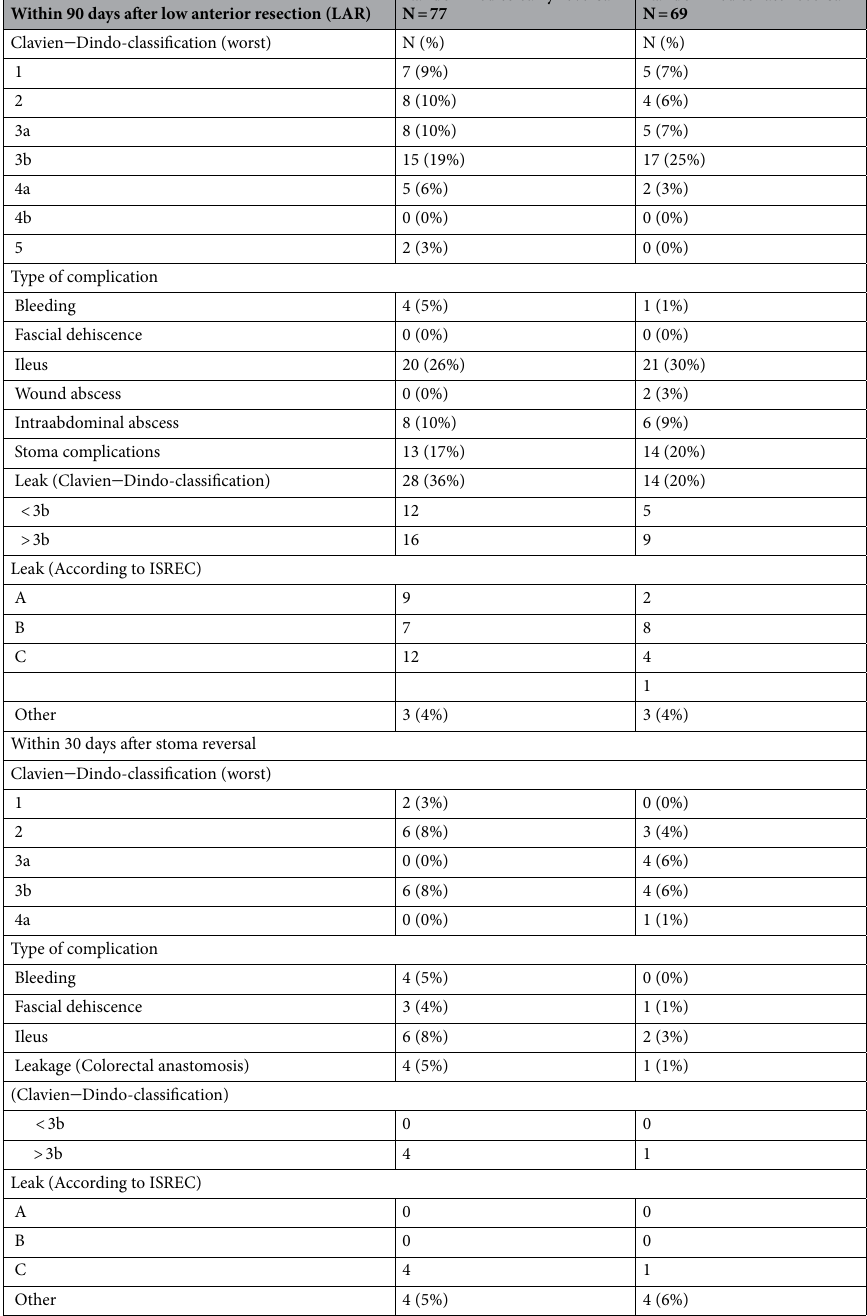
Table 2. Severity and type of postoperative complications in the two groups. A patient may have more than one